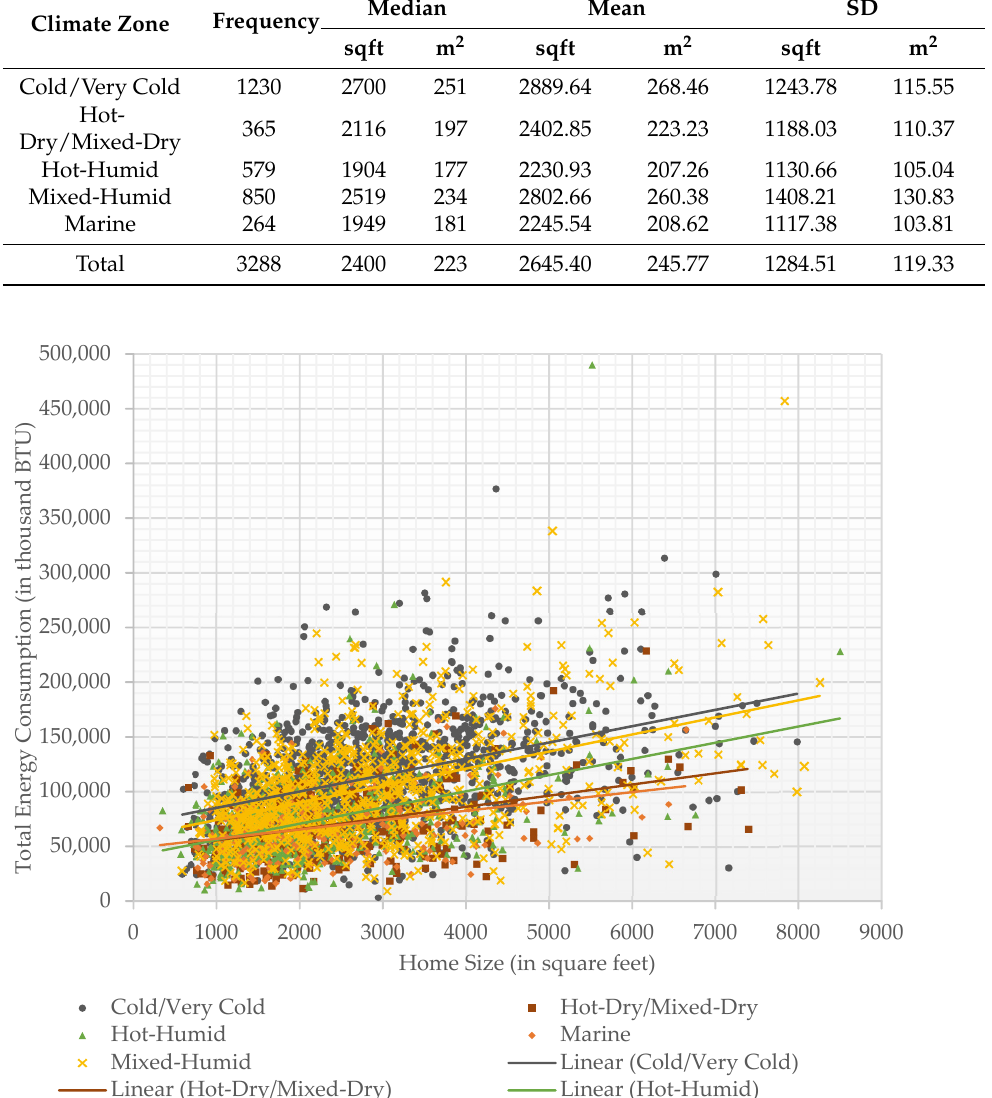
Figure 3. Box plot for the total square footage of homes per climate region.